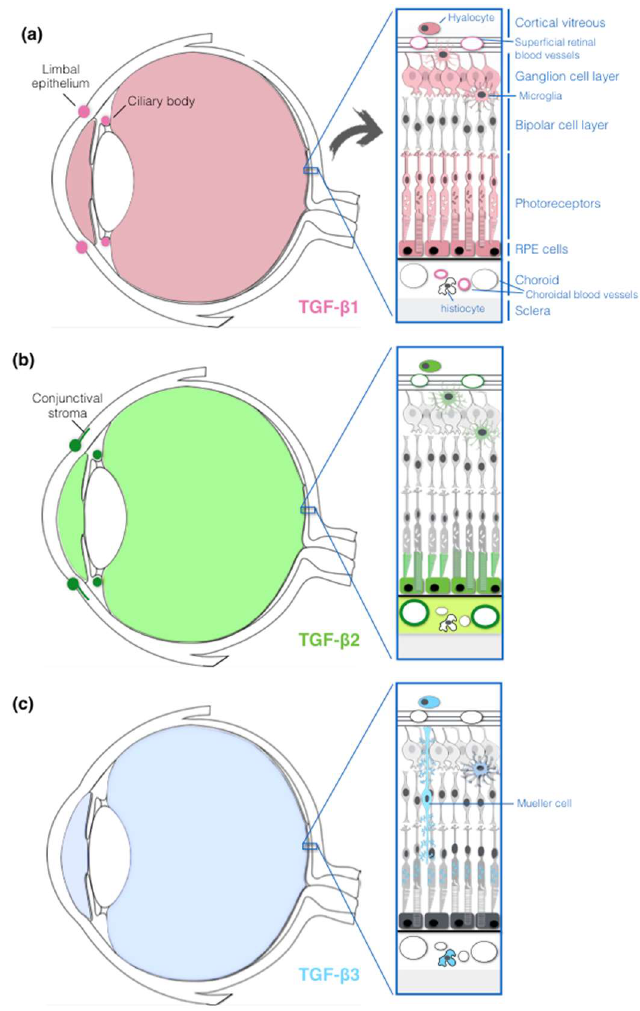
Figure 2. Drawing of a section through the human eye with a schematic enlargement of the retina layers. The TGF- β 1 ( a ), TGF- β 2 ( b ) and TGF- β 3 ( c ) expression in human eye structures and cells are indicated by different colors. See text for details.